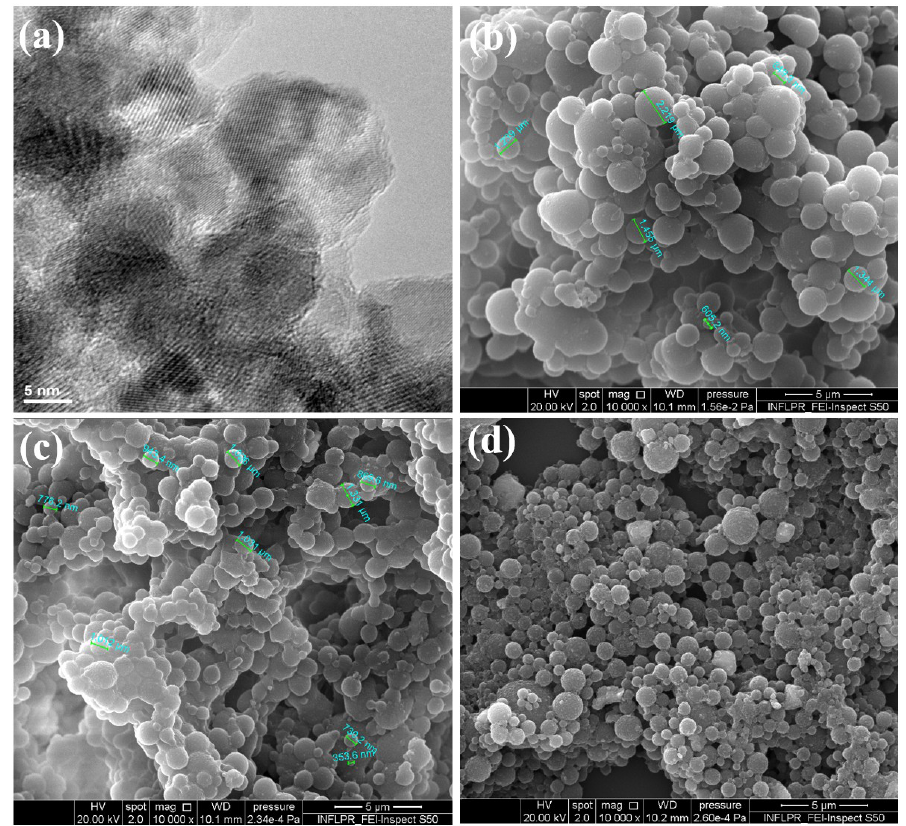
Figure 2. TEM image of ( a ) Fe 3 O 4 particles, and SEM images of ( b ) IBUP10, ( c ) IBUP20, and ( d ) IBUP50 biopolymeric spheres.